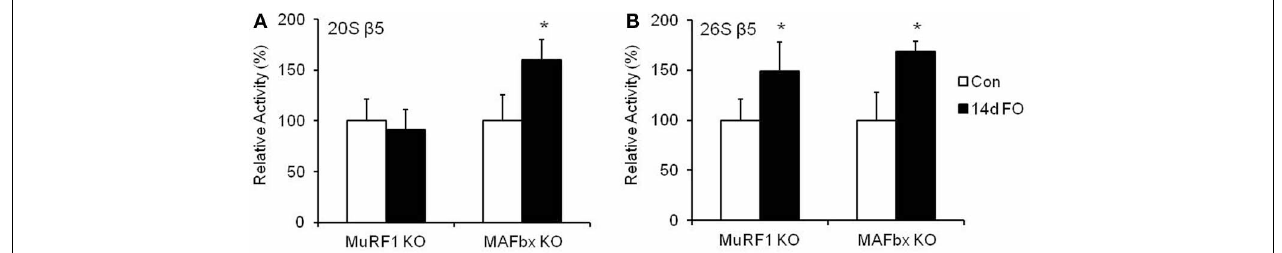
FIGURE 6 | Proteasome activity increases in MuRF1 and MAFbx null (KO) mice after 14 days of functional overload (FO). Proteolytic activity of the β 5 subunit of the 20S (A) and 26S (B) proteasome was assessed by fluorometric assay in MuRF1 and MAFbx KO mice